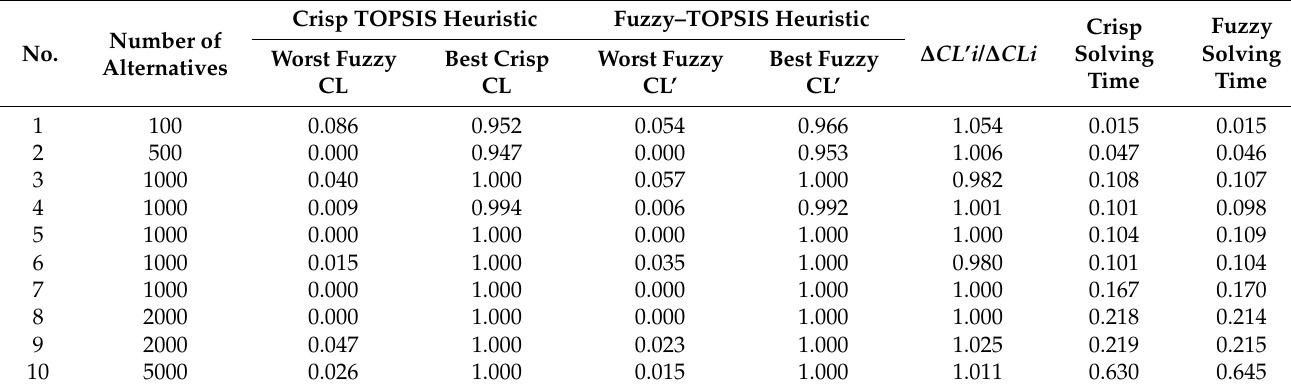
Table 12. Result of comparing crisp TOPSIS heuristic with the fuzzy–TOPSIS heuristic method.